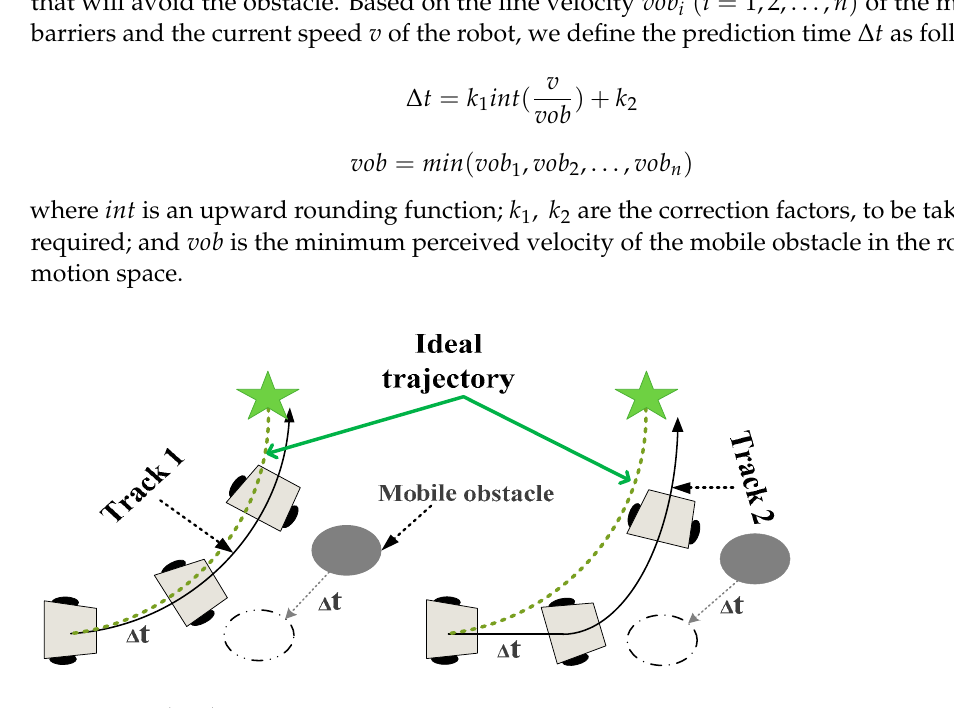
Figure 8. 𝑑𝑖𝑠𝑡(𝑣, 𝜔) mechanistic analysis. Figure 8. dist ( v , ω ) mechanistic